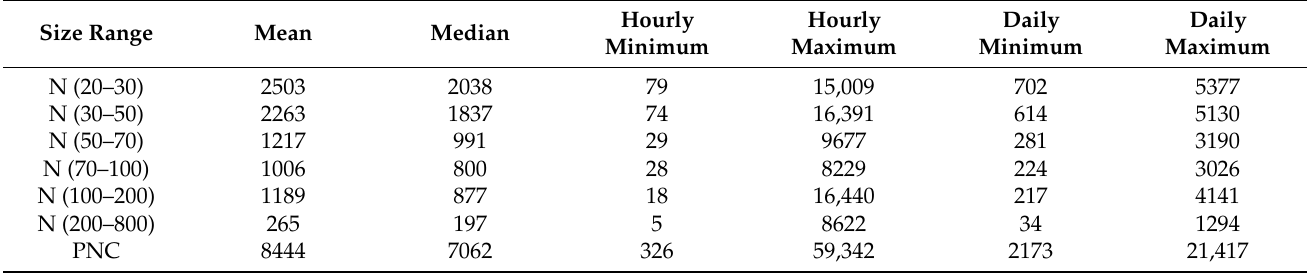
Table A2. Descriptive statistics of ultrafine particle number concentrations (particle/cm 3 ) over the measurement period on roadside site